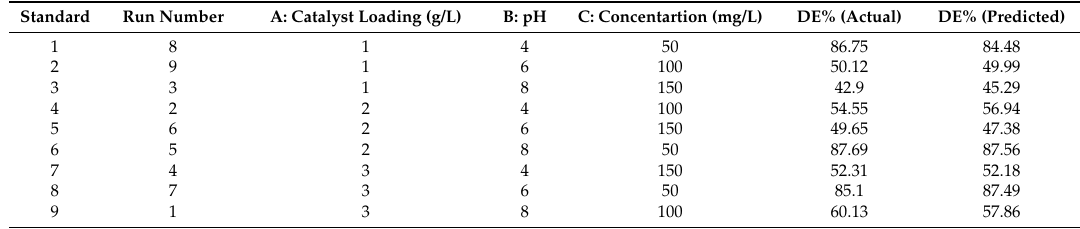
Table 6. Actual and predicted values of photocatalytic degradation efficiency percentage (DE%) of